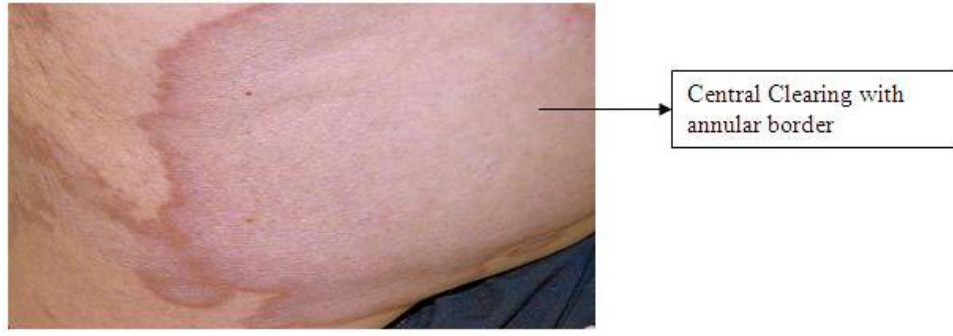
FIGURE 2. Right flank.